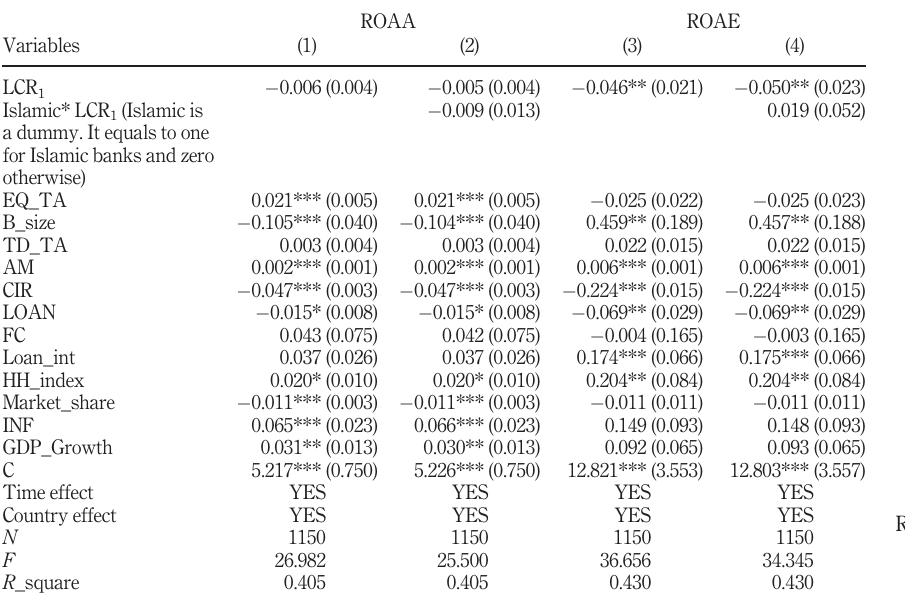
Table VIII. Regression